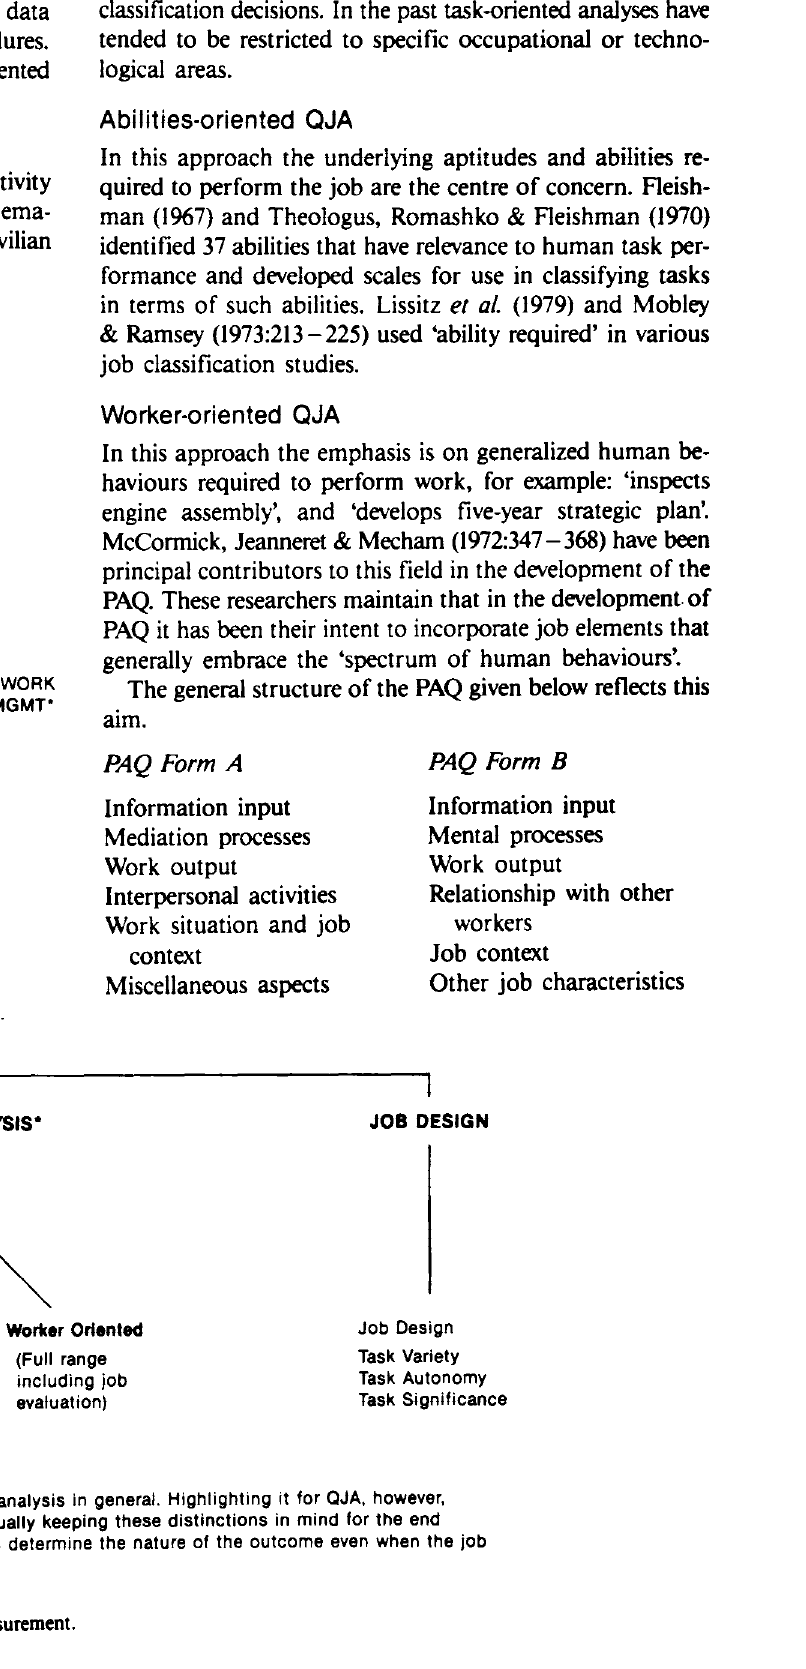
Figure 2 Behavioural science job